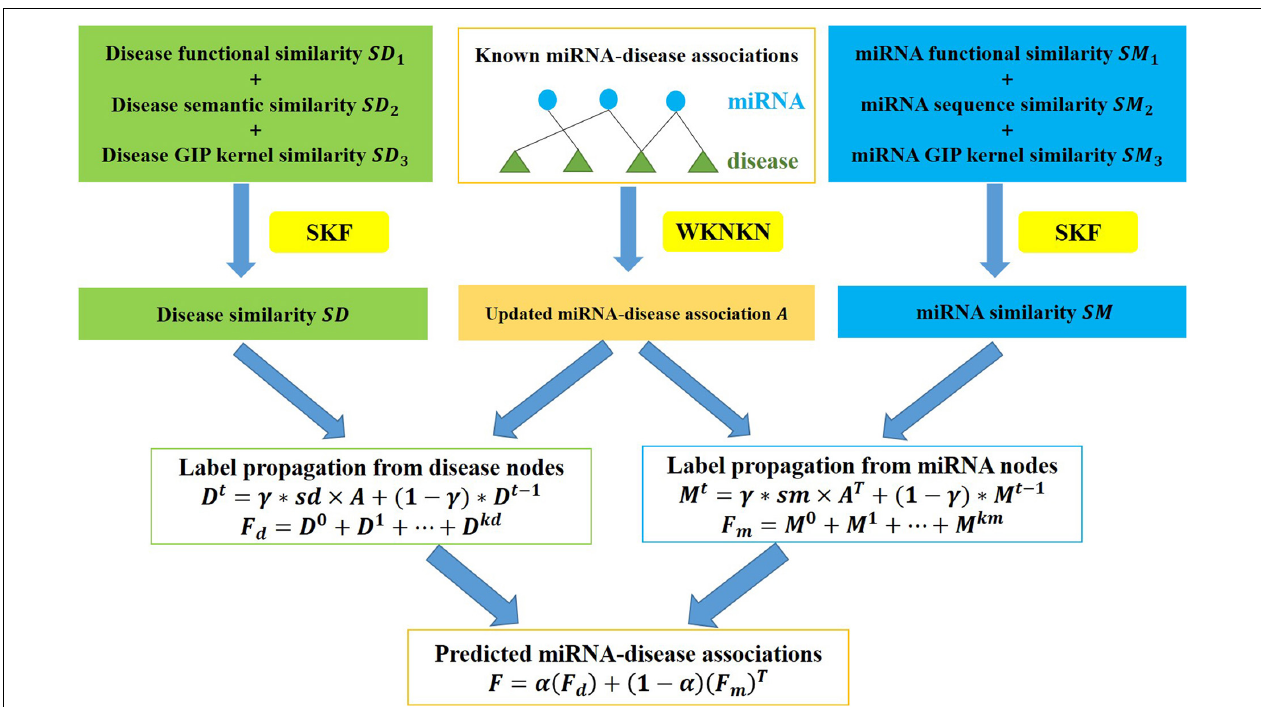
FIGURE 2 | Flow chart of ILPMDA to predict unknown associations based on the known associations in the HMDD v2.0 database.